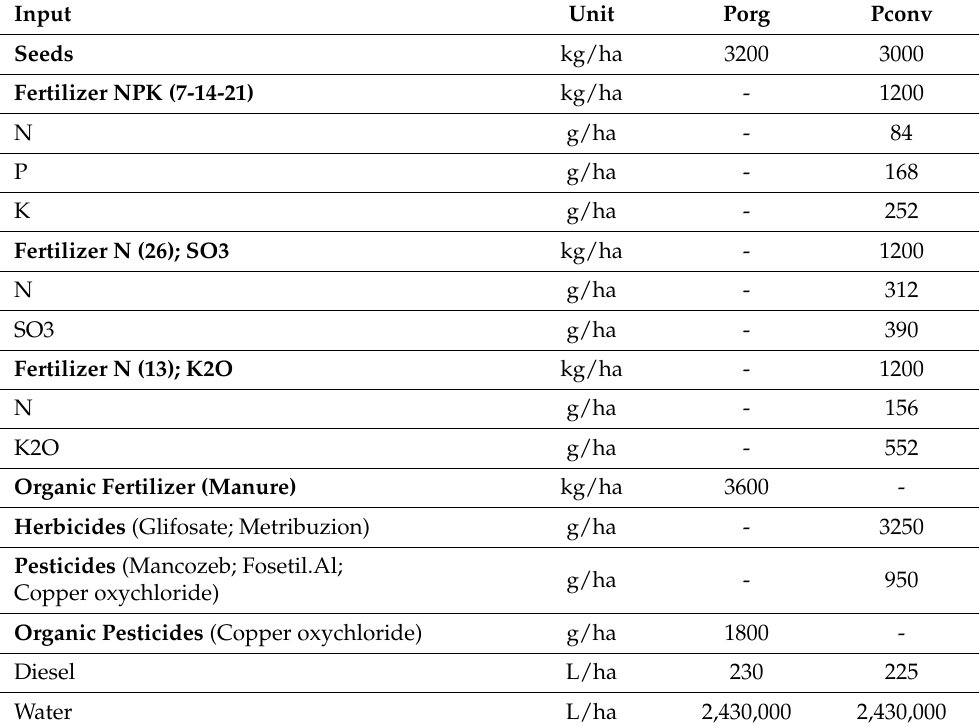
Table 2. Inputs used in early potato cultivation in organic and conventional farming (unit data)